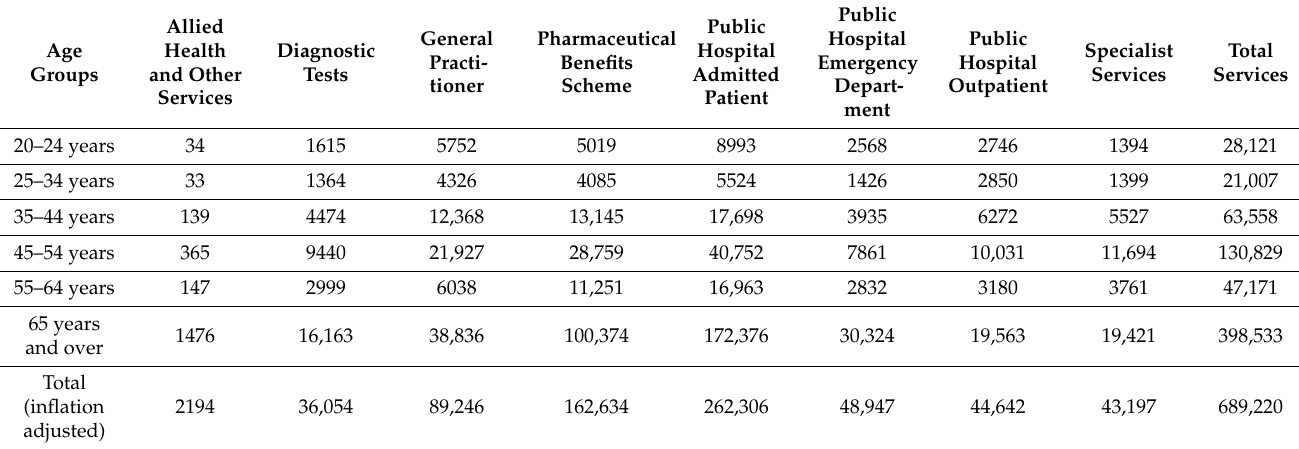
Table A13. Extra costs incurred due to LHL for people diagnosed with Respiratory disorders in the Blacktown LGA (Domain 9).